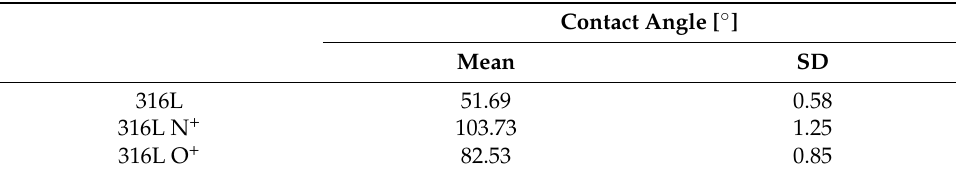
Figure 26. An example of contact angle. Table 8. Mean contact angle with distilled water.